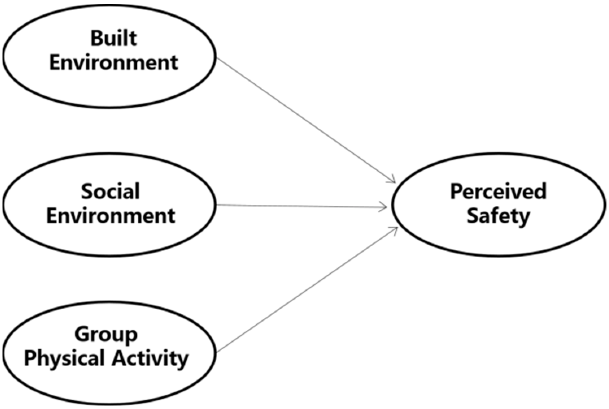
Figure 1. Elementary framework: the independent relationship between determinants and perceived safety.